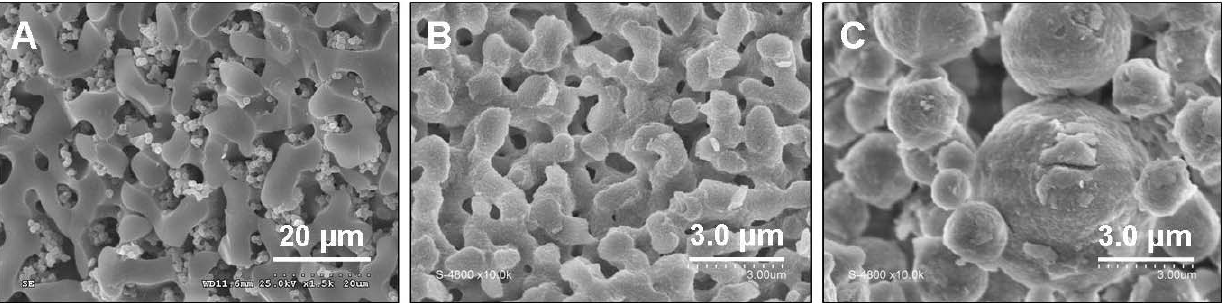
Figure 6. SEM images exhibiting the impact of the varying molar ratio of PEO (M on the resulting morphologies in the micrometre range ( A ) Al/PEO = 1/3.9 × 10 − 6 ; ( B ) Al/PEO = 1/4.5 × 10 − 6 ; ( C ) Al/PEO = 1/5.1 × 10 − 6 .